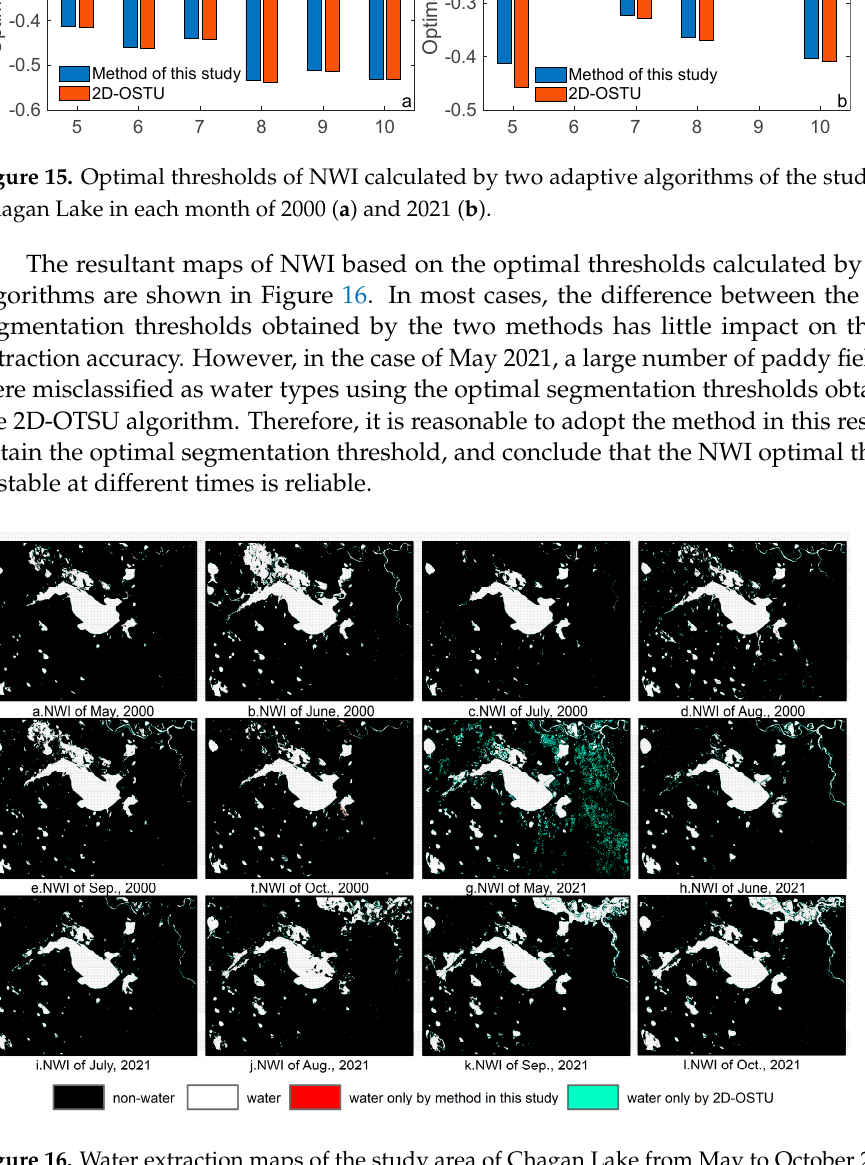
Figure 16. Water extraction maps of the study area of Chagan Lake from May to October 2000 ( a – f ) and 2021 ( g – l ) based on NWI with optimal thresholds adopted by the two algorithms. and 2021 ( g – l ) based on NWI with optimal thresholds adopted by the two